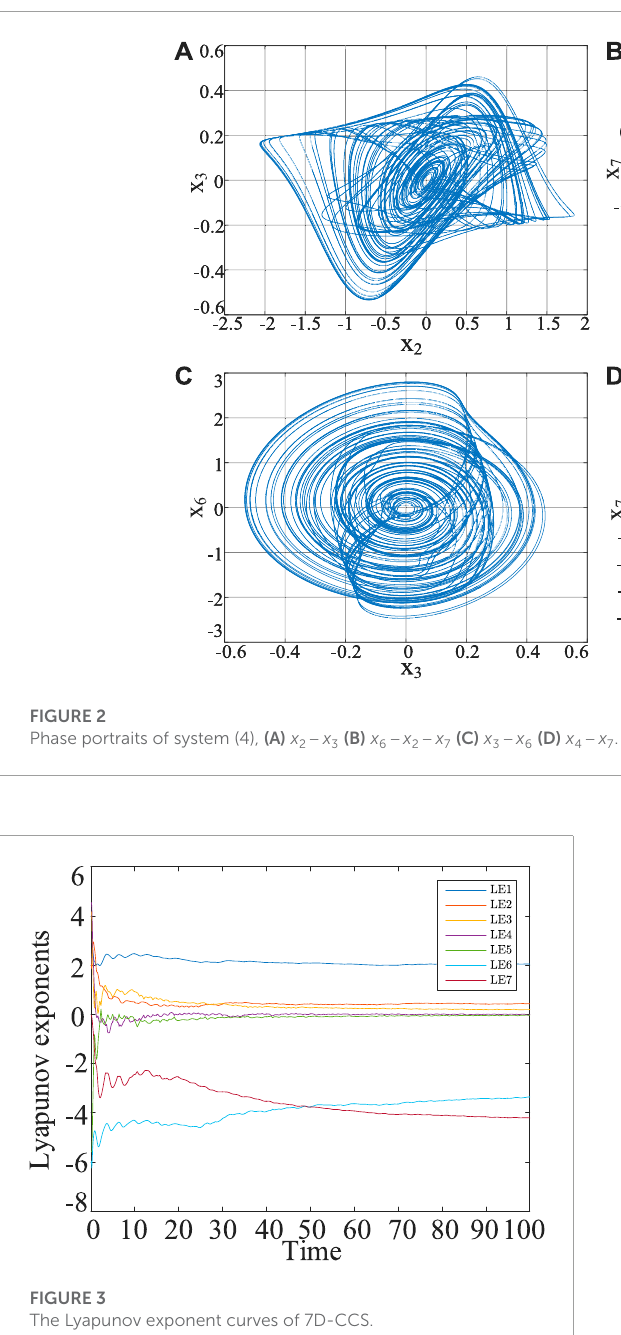
FIGURE 3 The Lyapunov exponent curves of 7D-CCS.